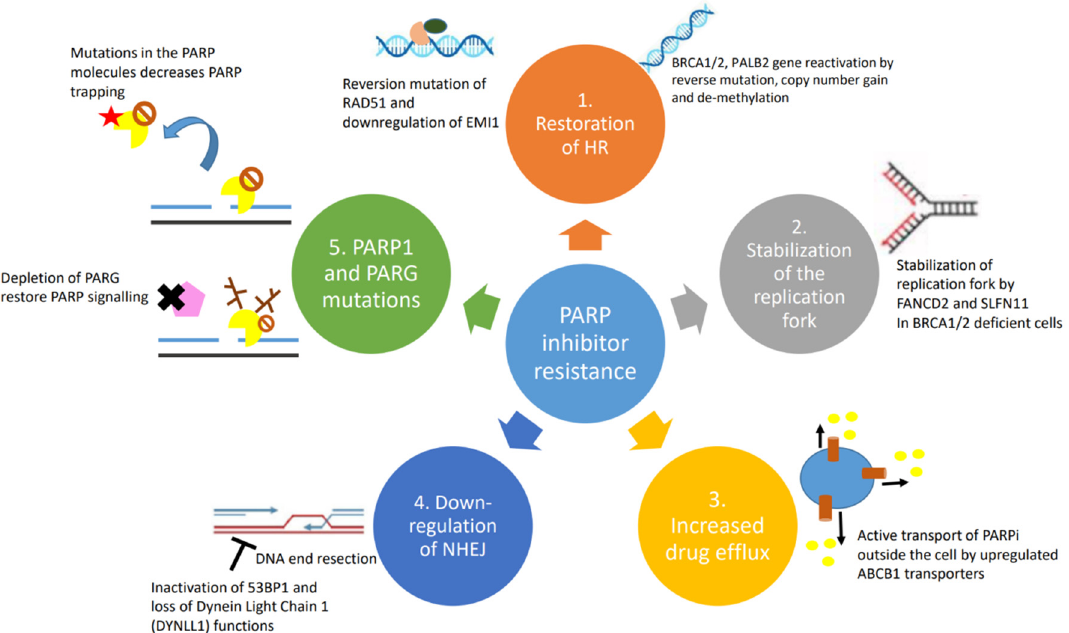
Figure 2. Causes and mechanisms of PARP inhibitor resistance: (1) restoration of homologous recombination; (2) stabilization of replication fork; (3) upregulation of drug efflux pumps; (4) down- regulation of NHEJ; and (5) PARP1 and PARG mutations.